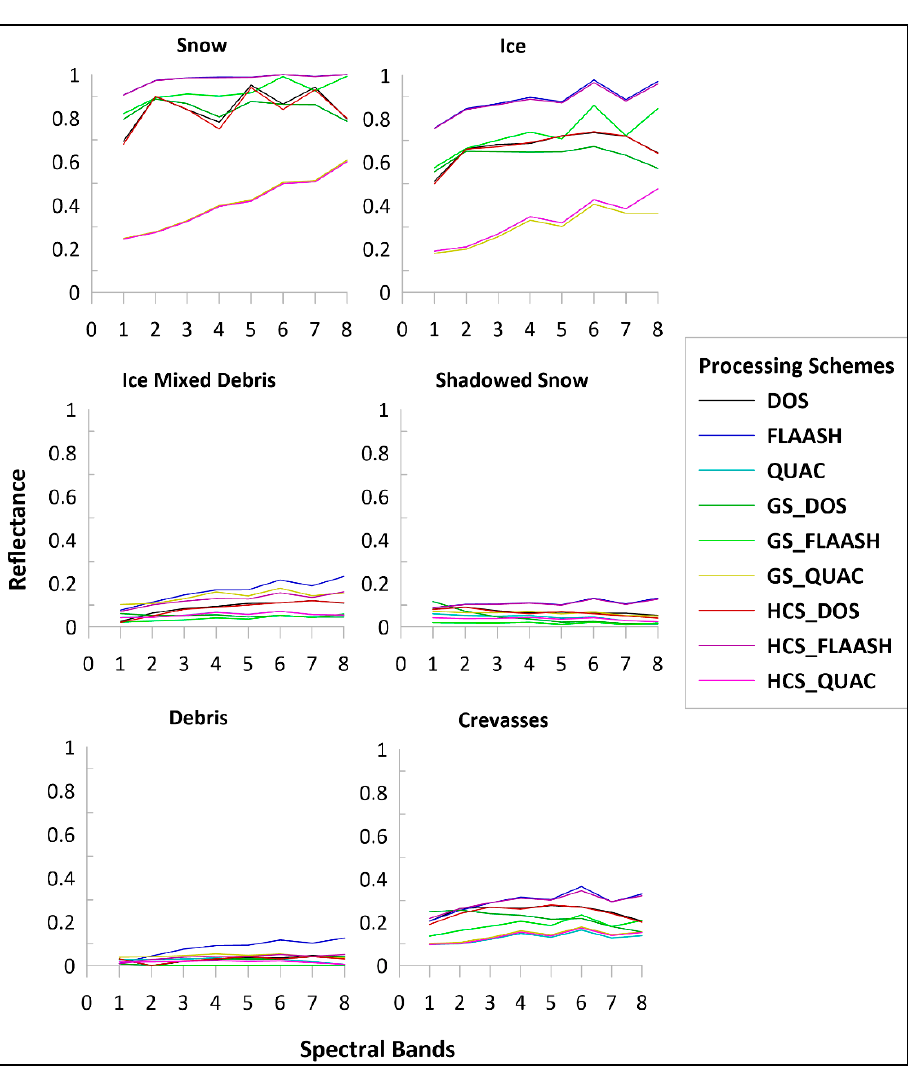
Figure 4. Difference in spectral response of facies in Chandra–Bhaga Basin for the processing schemes. 1: Band 1 = Coastal; 2: Band 2 = Blue; 3: Band 3 = Green; 4: Band 4 = Yellow; 5: Band 5 = Red; 6: Band 6 = Red Edge; 7: Band 7 = NIR 1; 8: Band 8 = NIR 2.